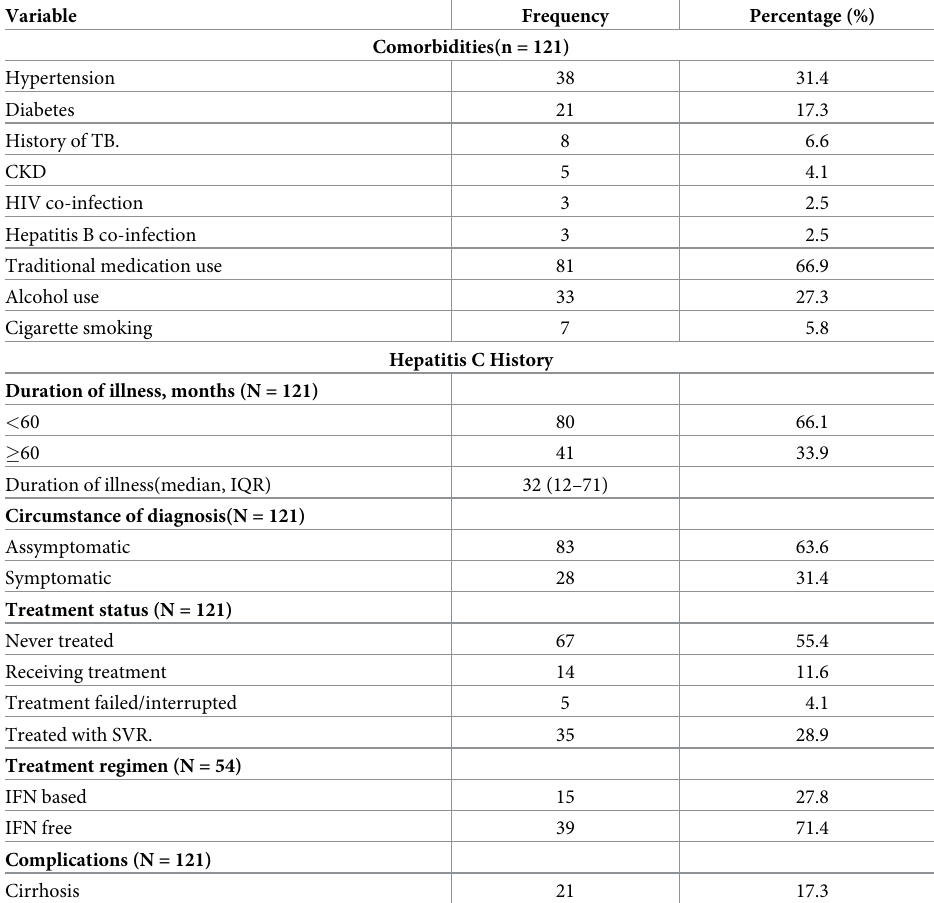
Table 2. Medical history of study